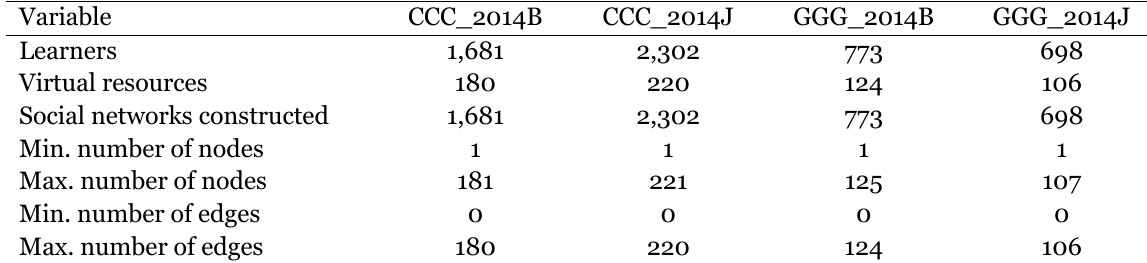
Summary of Data for Social Networks of Each Learner in Courses CCC and GGG in 2014